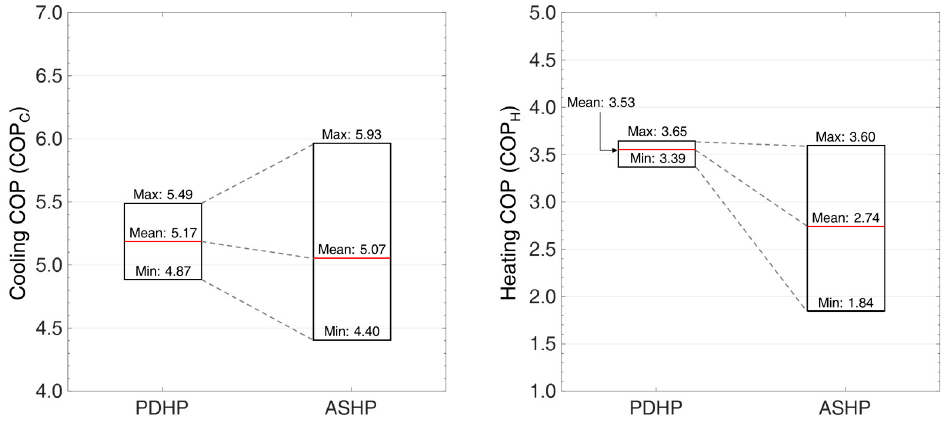
Figure 13. Comparison of cooling and heating COPs of PDHP with ASHP.